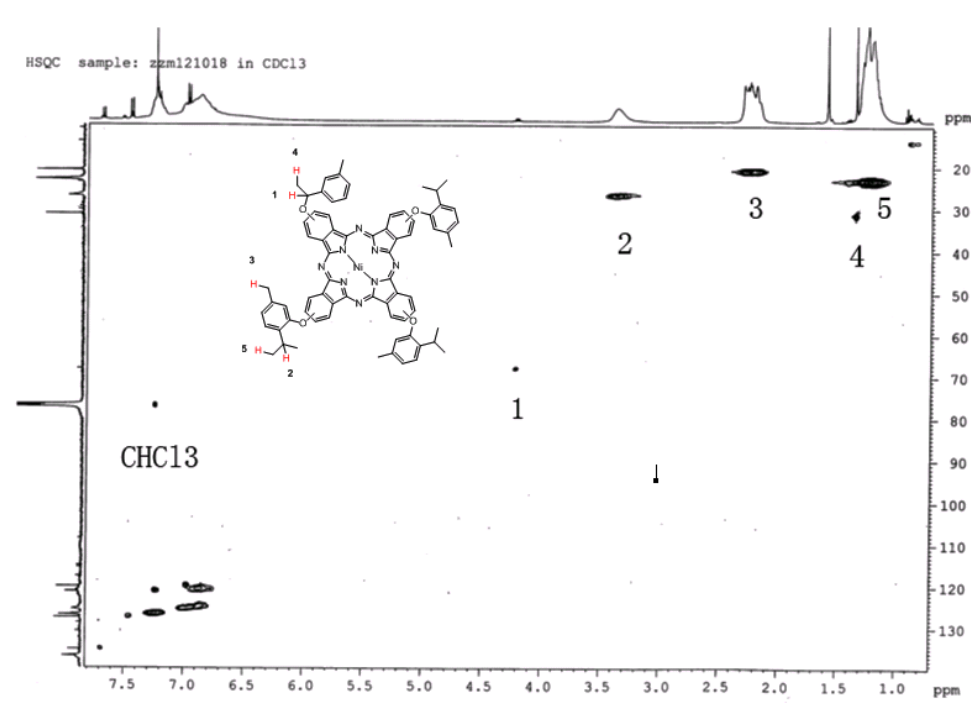
Figure 2. The 1 H- 13 C-NMR of 1a